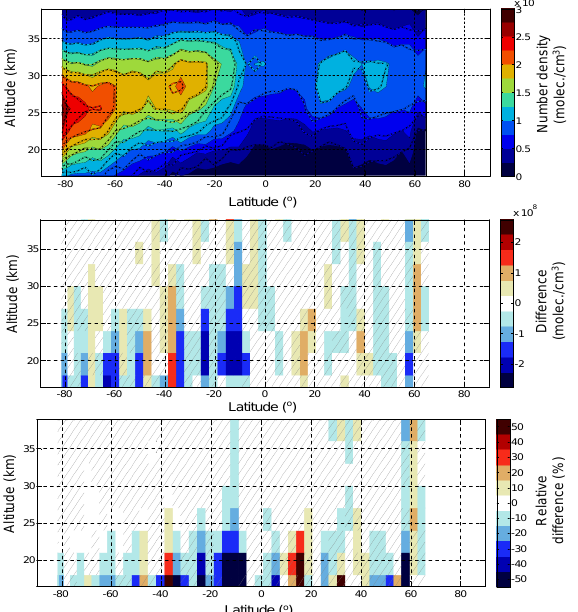
Fig. 5. Same as Fig. 4 but for orbit 35503.